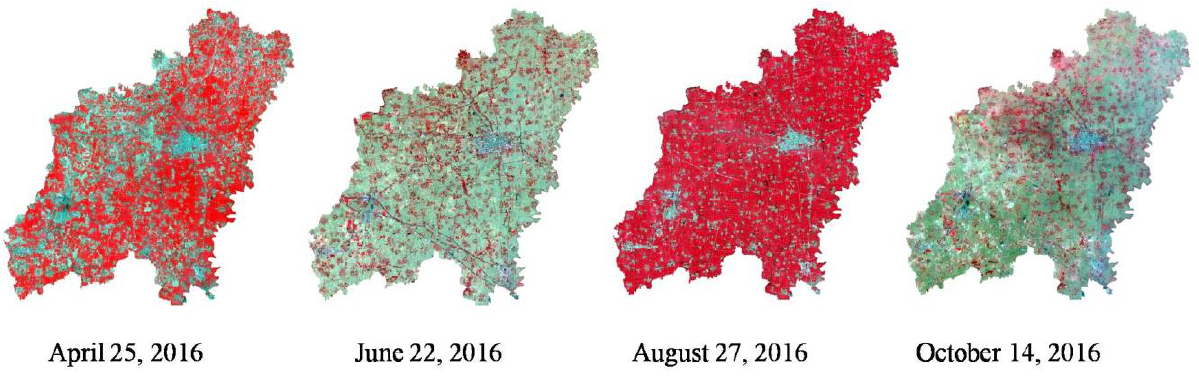
Figure 2 ． Preprocessing of remote sensing